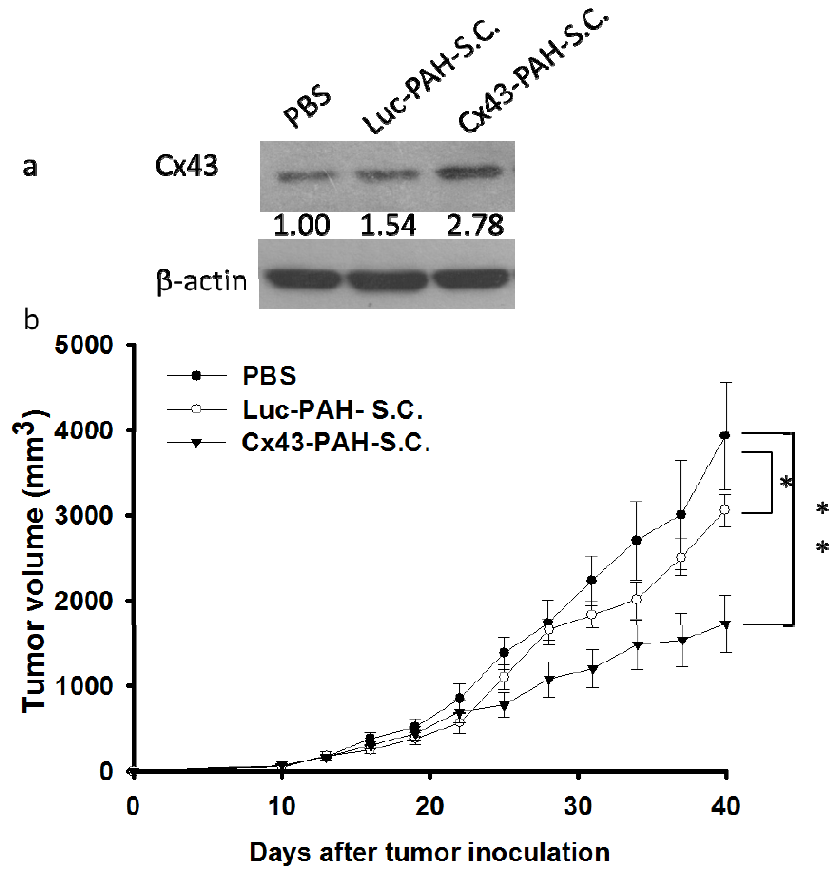
Figure 5. The antitumor effects of Cx43-PAH-S.C. on mice. Mice bearing 4T1 tumors were injected i.v. with PAH-S.C. (2 × 10 6 cfu) or Cx43-PAH-S.C. (2 × 10 6 cfu) on day 7. The vehicle control mice received PBS. ( a ) Cx43-PAH-S.C. induced Cx43 protein expression in tumors in vivo . 4T1-established tumors were treated with PBS, PAH-S.C., or Cx43-PAH-S.C. Three days later, the mice were killed, the tumors were collected, and the tumor lysates were analyzed for Cx43 expression using immunoblot analysis; and ( b ) Tumor volumes (mean ± SEM, n = 8) from mice bearing 4T1 tumors were compared among the different treatment groups. * p < 0.05; ** p <